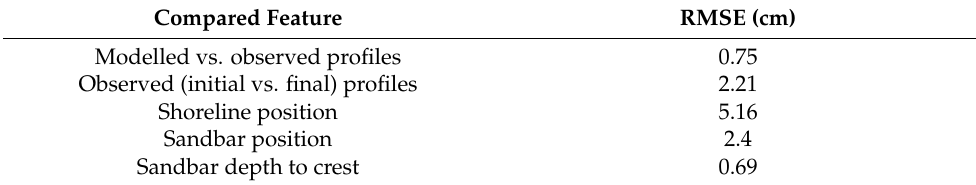
Figure 9. ( a ). Comparison between the cross-shore location of the modelled (dots) and observed (squares) shoreline (magenta vs. cyan) and main breaker bar (red vs. blue). ( b ). Comparison between the modelled (red dots) and observed (blue squares) depth over the crest of the main breaker bar. Table 2. Root mean square error between the final observed and modelled beach profile and between the observed and modelled beach features for all profiles for the erosive case A. Errors are calculated within the active transport zone (i.e., from depth of closure to the run up limit for the erosive wave